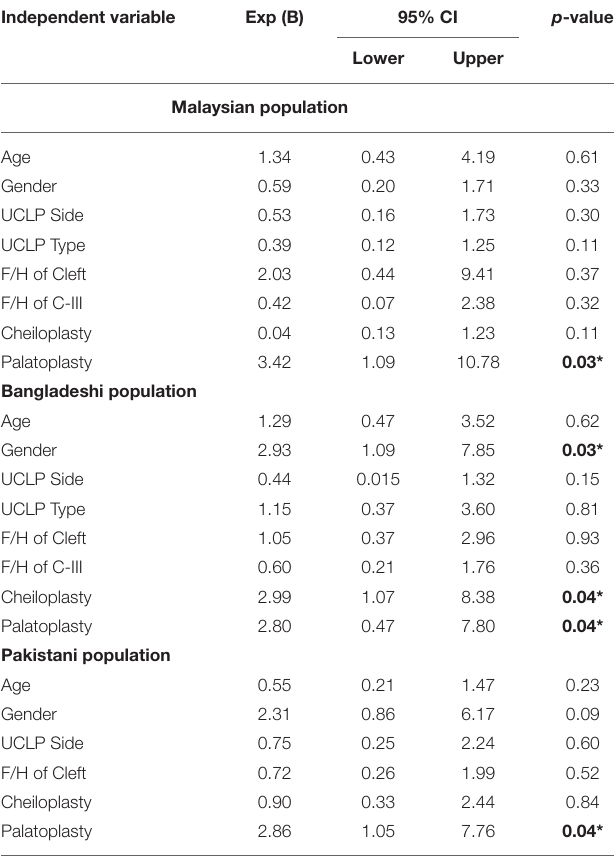
TABLE 4 | Logistic regression analysis of multiple factors with treatment outcome (Favourable vs. unfavourable group) using GY in three population. Independent